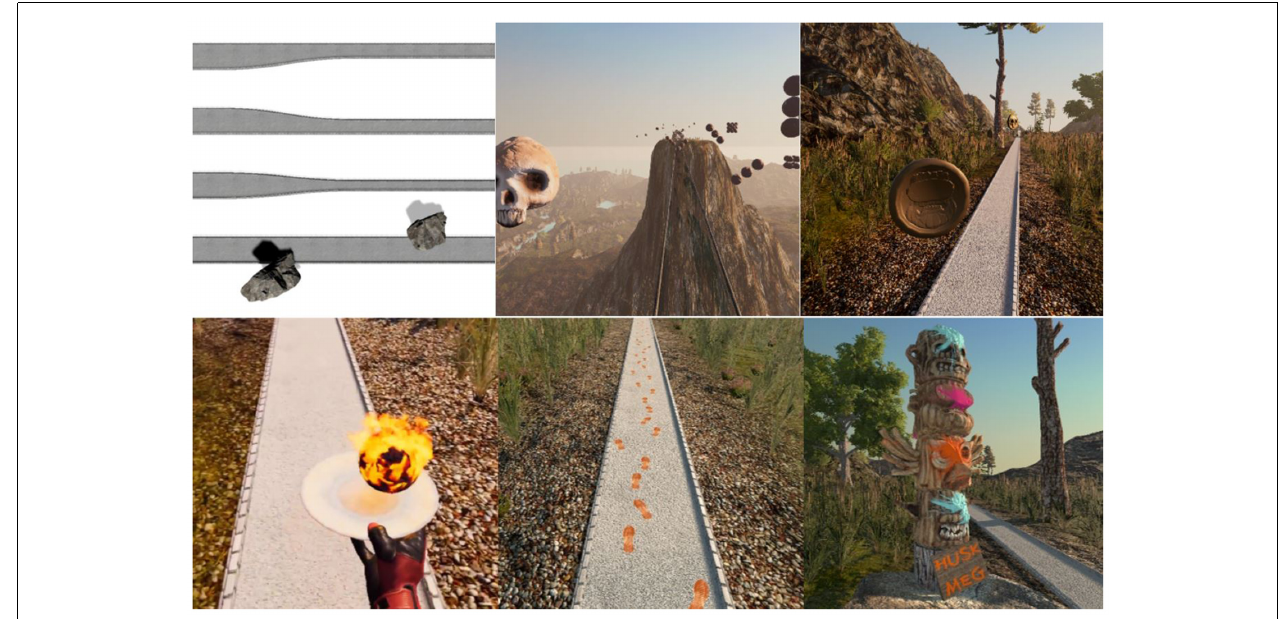
FIGURE 3 | The tasks of VR Walk (from upper left): Path adjustments. Glass bridge (with axe throwing). Coin collection. Balance ball. Footsteps. Memorize.